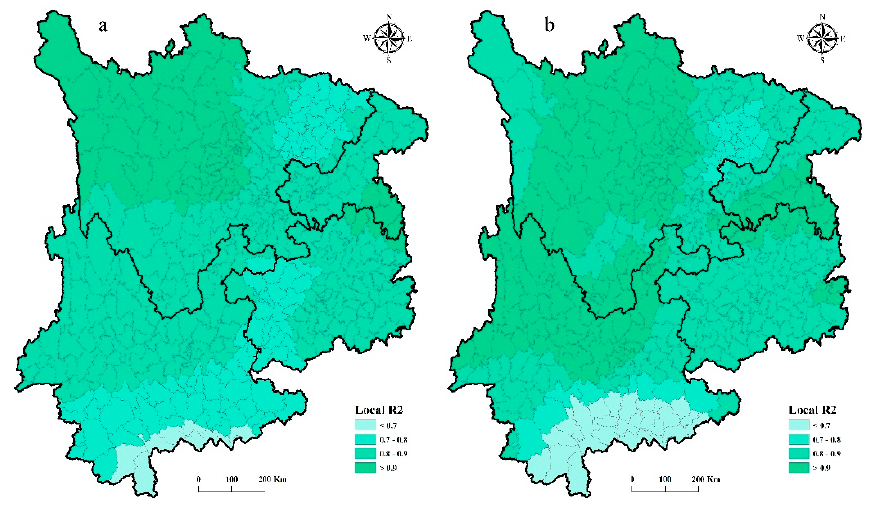
Figure 3. Maps of local R 2 : ( a ) GWR; ( b ) s-GWR.